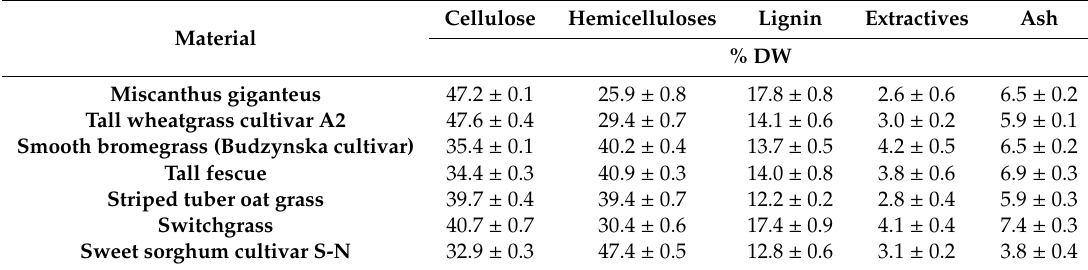
Table 1. Chemical composition of the tested lignocellulosic materials.